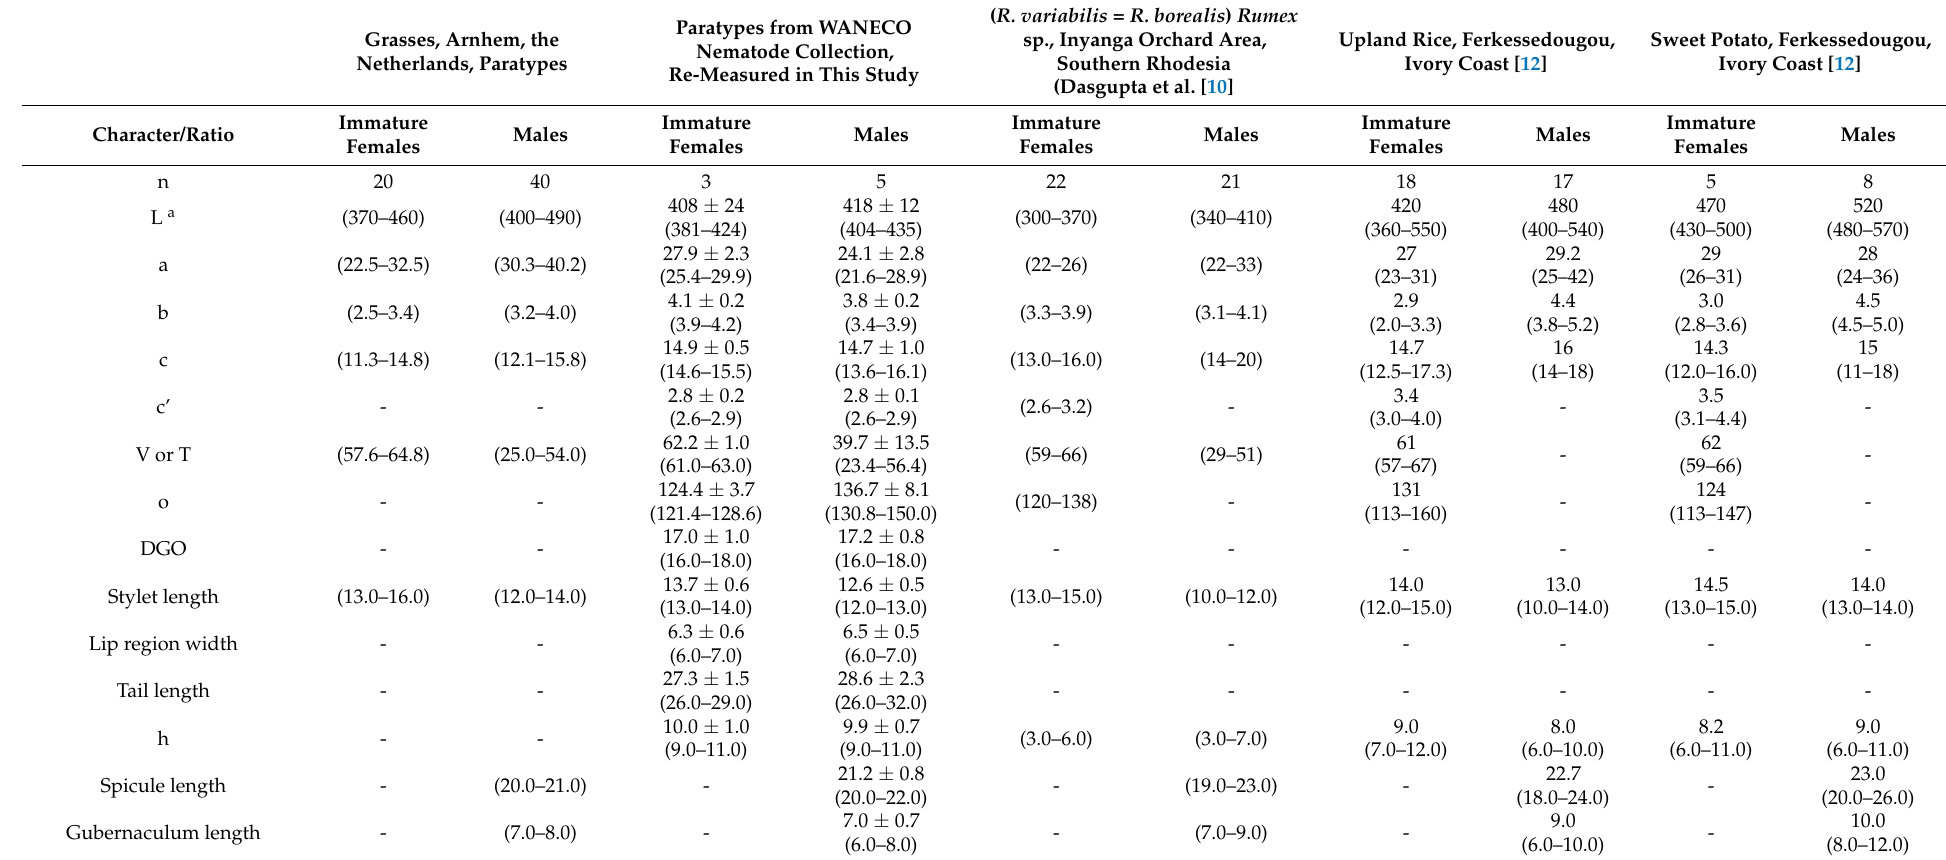
Table 2. Measurements of immature females and males of Rotylenchulus borealis from type locality in the Netherlands and several localities in Africa. All measurements are in micrometers and in the form mean ± SD